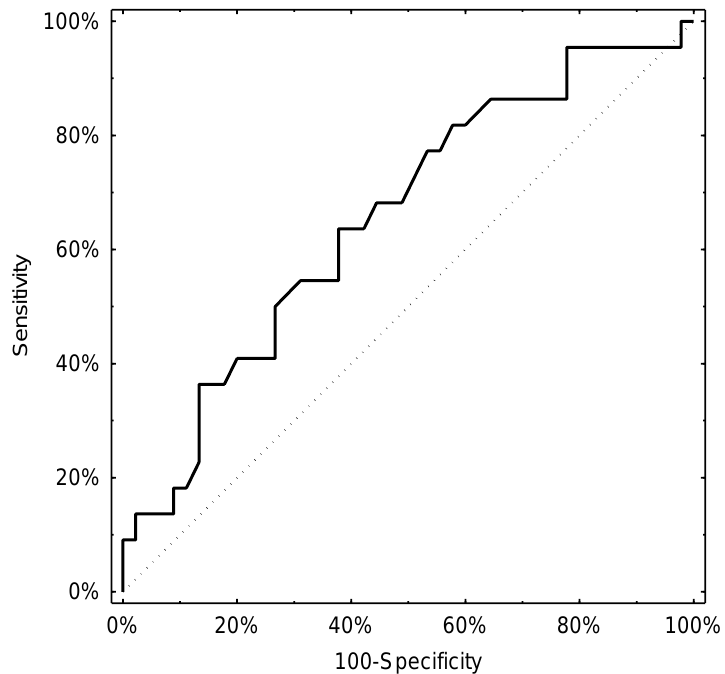
Figure 2. ROC curve derived from the total number of reflux episodes and lesions in gastroscopy.